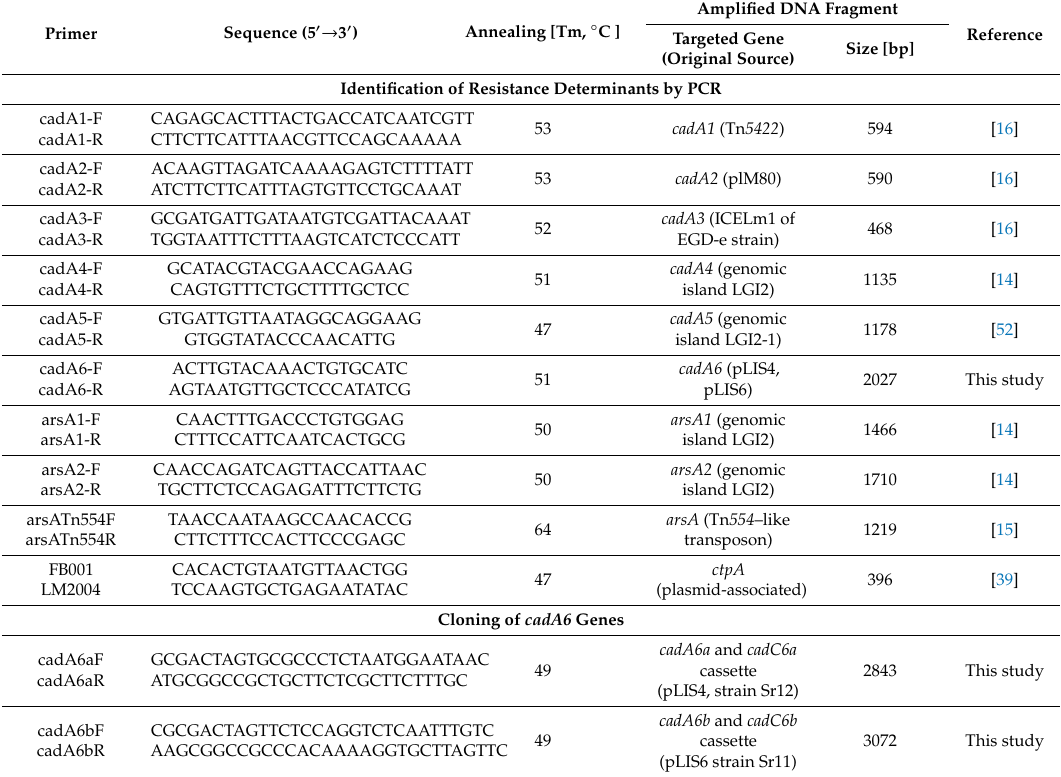
Table 1. Primers used in PCRs to amplify resistance